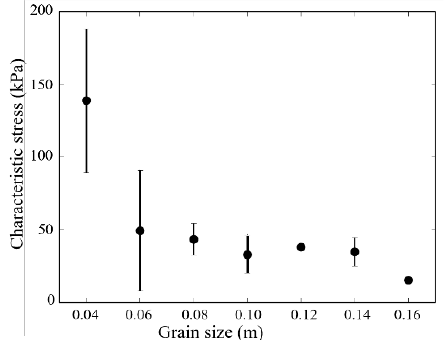
Fig. 2. Compression test of a grain and breakage stress σ R for grains of different sizes for a set of parameters ( C n =10 3 kPa, μ=0.4 ).